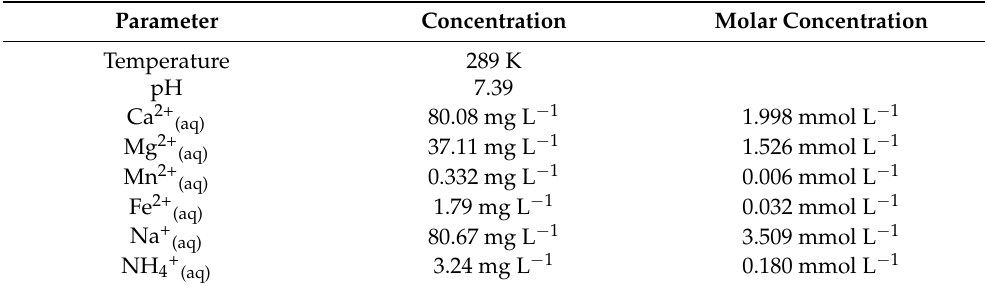
Table 1. Monitored physical–chemical characteristics of investigated groundwater.